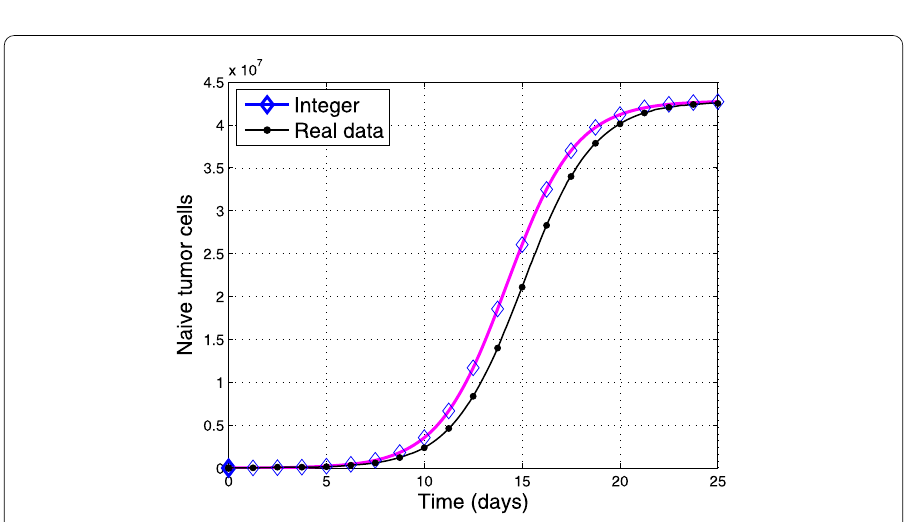
Figure 2 The growth of naive tumour cell population derived by the classical integer model versus the real data of tumour growth used in [49] and [29]